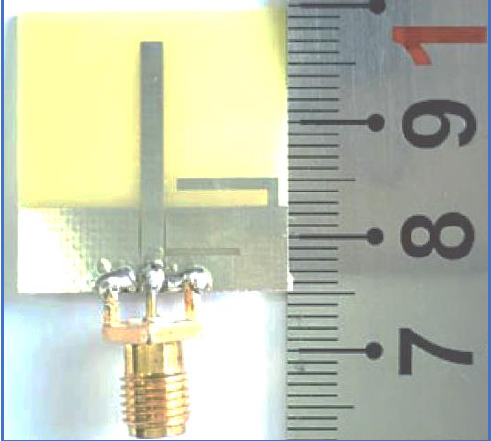
Figure 24. The geometry of a CPW-fed straight monopole antenna [128].